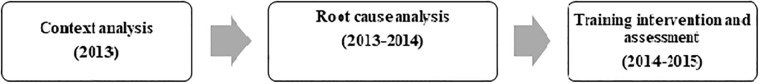
Flow of study activities in this action research.